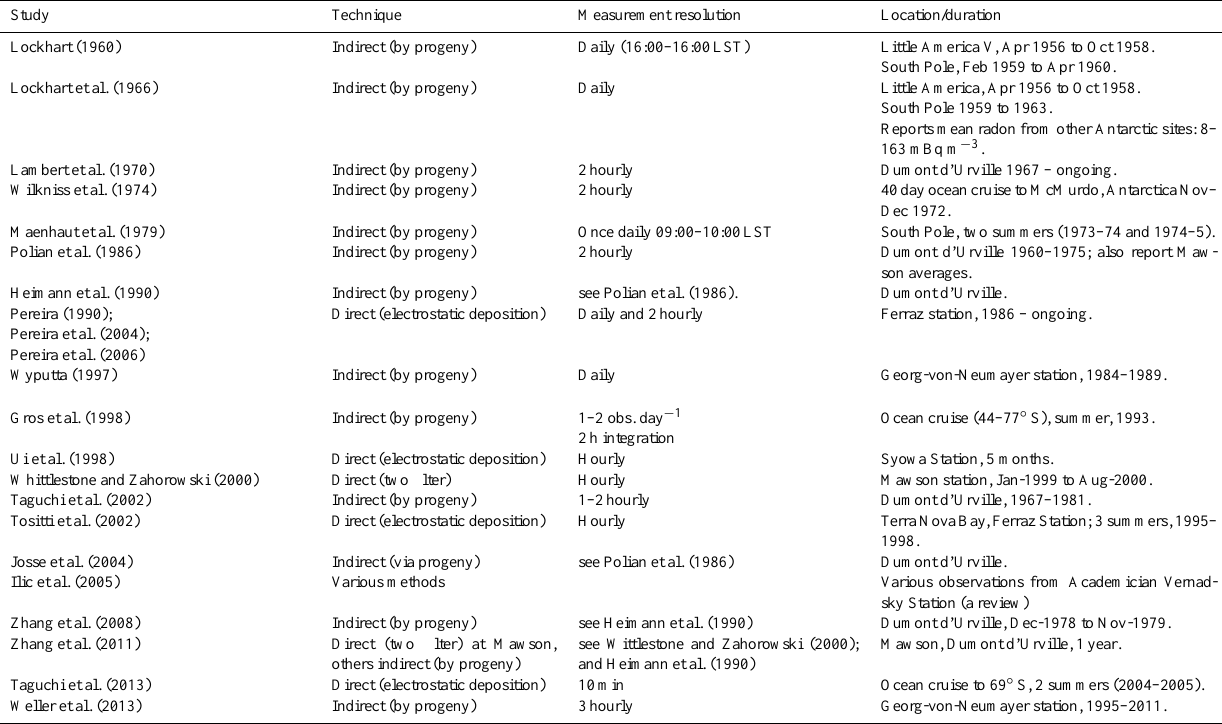
Table 1. Summary of previous radon observations in the